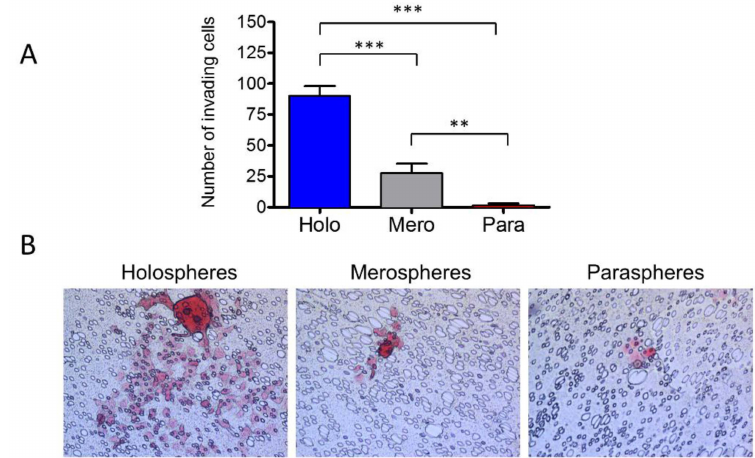
Figure 5. Holospheres have increased invasive potential. ( A and B ) Invasion assay of tumor spheres derived from holospheres, merospheres, and paraspheres. Holospheres show increased invasion compared to merospheres (*** p < 0.001) and paraspheres (*** p < 0.001). Merospheres invade significantly more than paraspheres (** p < 0.01).